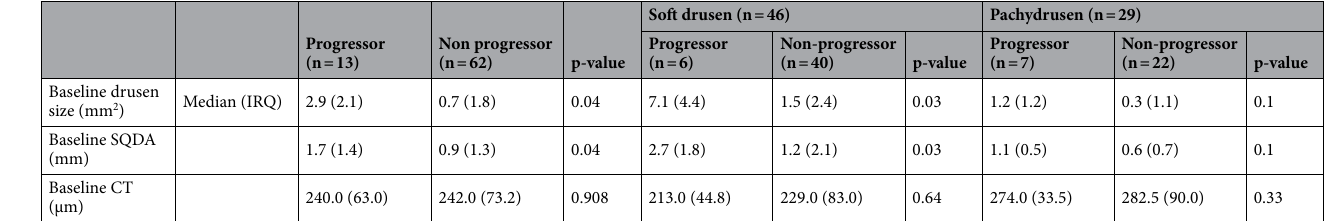
Table 3. Baseline characteristics of incident exudative nAMD and stratified by drusen